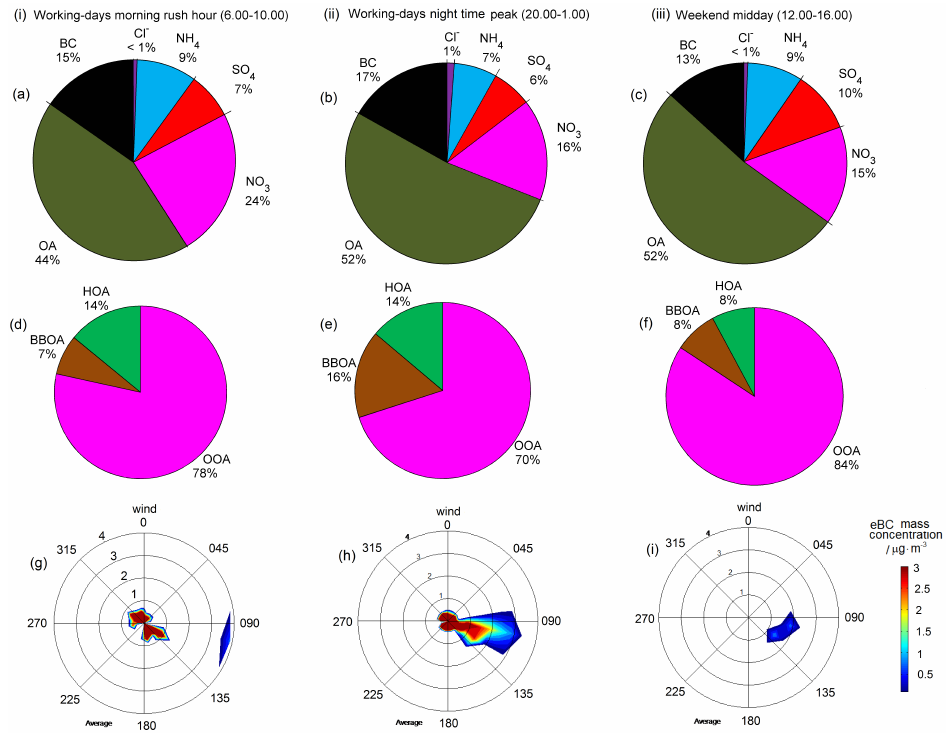
Figure 11. Aerosol composition and sources, and wind rose during during ( i ) the week-day morning rush hour (panels ( a ); ( d ); ( g )); ( ii ) the week-day night peak (panels ( b ); ( e ); ( h )); and ( iii ) the weekend midday (panels ( c ); ( f ); ( i )). Panels ( a )–( c ) show mean percentage contributions of major PM 1 components. Panels ( d )–( f ) show mean percentage contributions of vehicular traffic emission (HOA), biomass burning emission (BBOA) and Oxygenated secondary aerosol (OOA) to OM fraction. Panels ( g )–( i ) show average eBC mass concentration vs. both wind speed and direction (only data under no dust conditions are